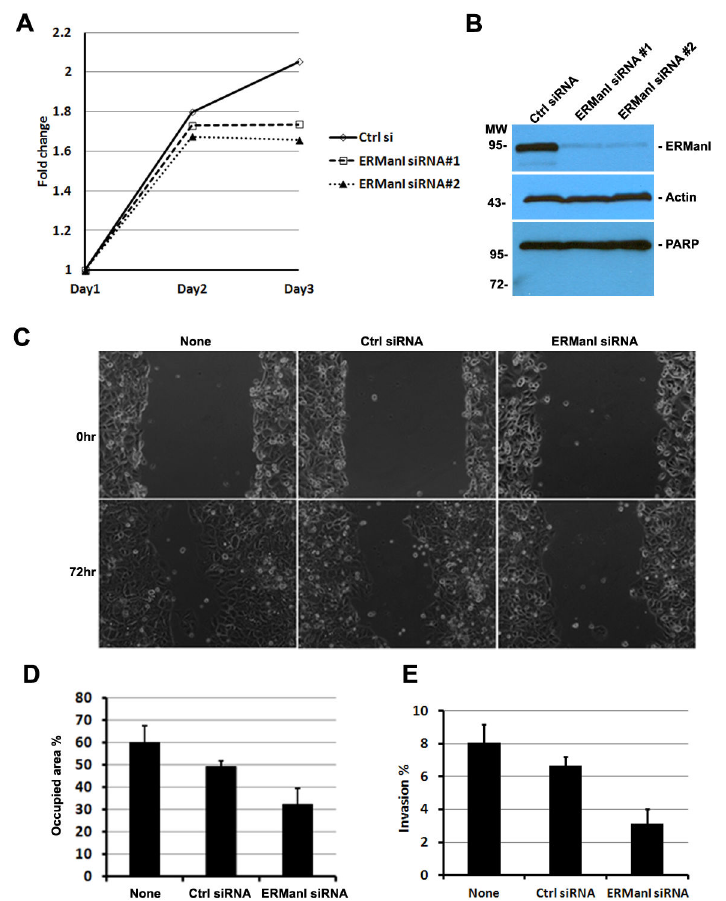
Figure 3. Downregulation of ERManI inhibits transformation phenotypes of PLC/PRF5 cells. A . Growth curve of PLC/PRF5 cells after transfection with control siRNA or two separate ERManI siRNAs #1 and #2 for 3days. B . Phase contrast images of non- transfected PLC/PRF5 cells or PLC/PRF5 cells transfected with control siRNA or ERManI siRNA at 0hr or 72hr after wound scratching. C . Average of the wounded areas occupied by non-transfected or siRNA-transfected PLC/PRF5 cells at 72hr post- scratching. Error bars represent standard deviations. D . Non-transfected PLC/PRF5 cells or PLC/PRF5 cells transfected with control siRNA or ERManI siRNA were subjected to the invasion assay, and the percentage of invaded cells were calculated against the total number of cells seeded. Error bards represent standard deviations from three repeated